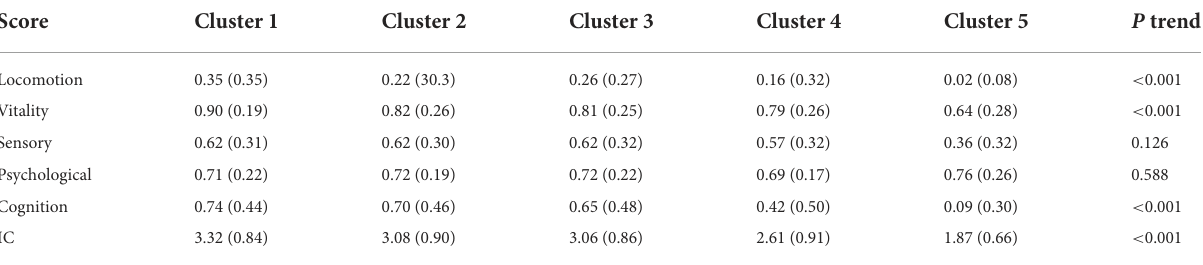
TABLE 2 Intrinsic capacity (IC) and domain scores by clusters among the